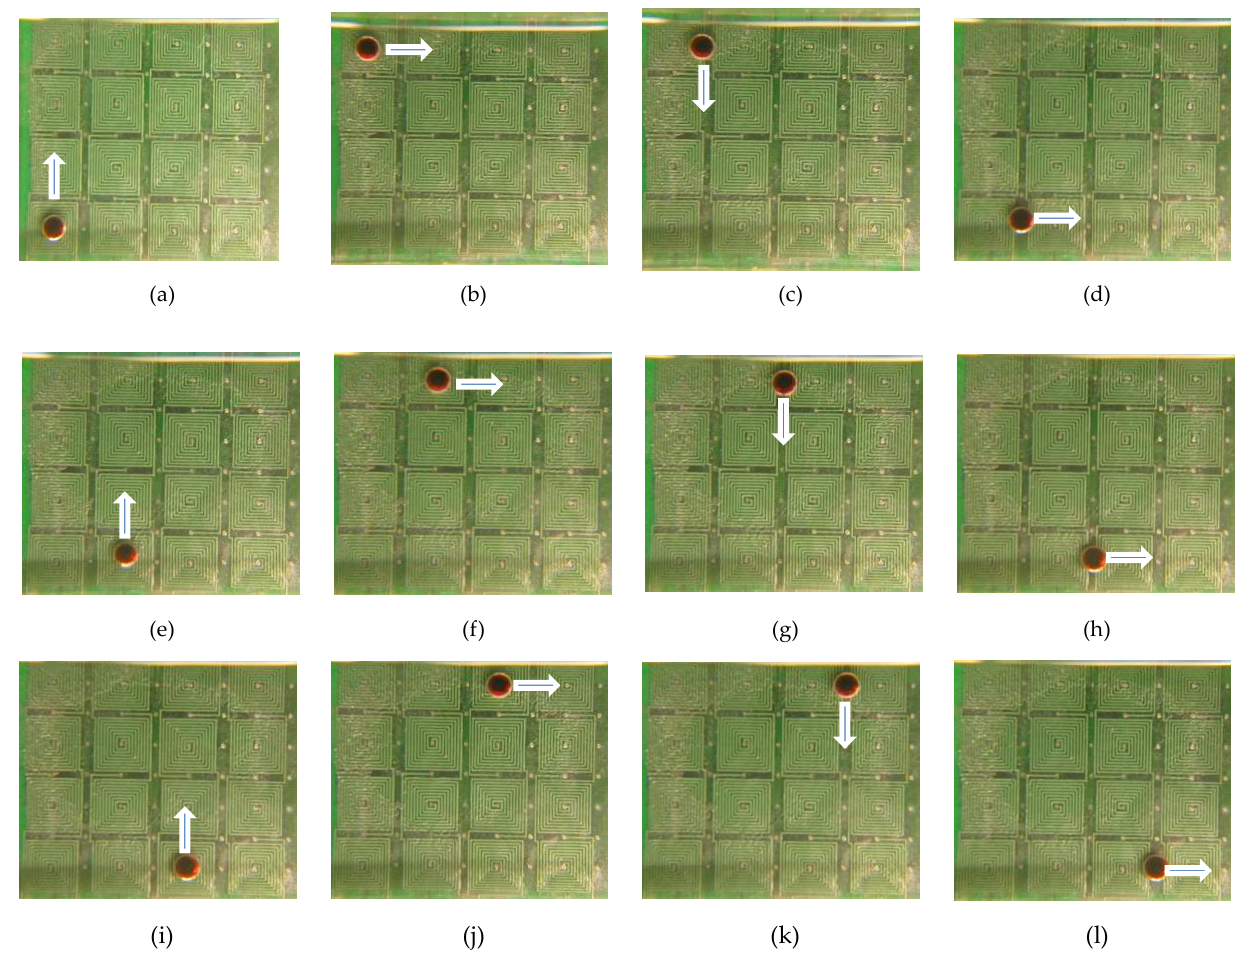
Figure 12. Water droplet moves along the two-layer 4 × 4 array micro-coils chip at different times. ( a ) t = 0; ( b ) t = 3.0 s; ( c ) t = 3.5 s; ( d ) t = 6.5 s; ( e ) t = 7.0 s; ( f ) t = 10.0 s; ( g ) t = 10.5 s; ( h ) t = 13.5 s; ( i ) t = 14.0 s; ( j ) t = 17.0 s; ( k ) t = 17.5 s; and ( l ) t = 20.5 s. The white arrows indicate the motion direction .